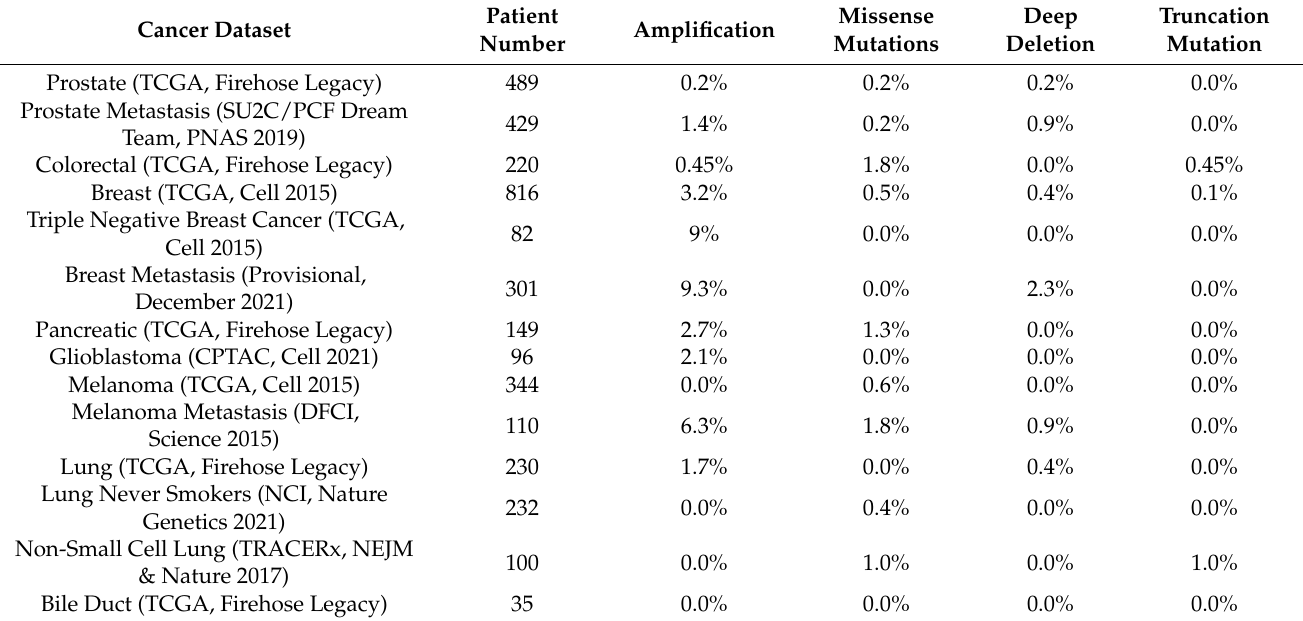
Table 1. Incidence and types of ALDH1A3 mutations in cancers that have been reported to be affected by ALDH1A3 expression. The information and the patient datasets were accessed and obtained via